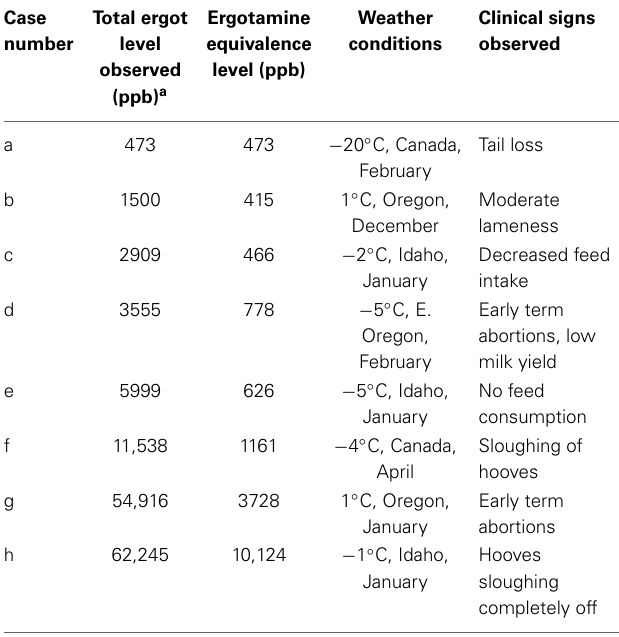
Table 2 | Clinical evaluation of ergot toxicosis in cattle with ergotamine equivalence levels (ppb) in feed on a dry weight